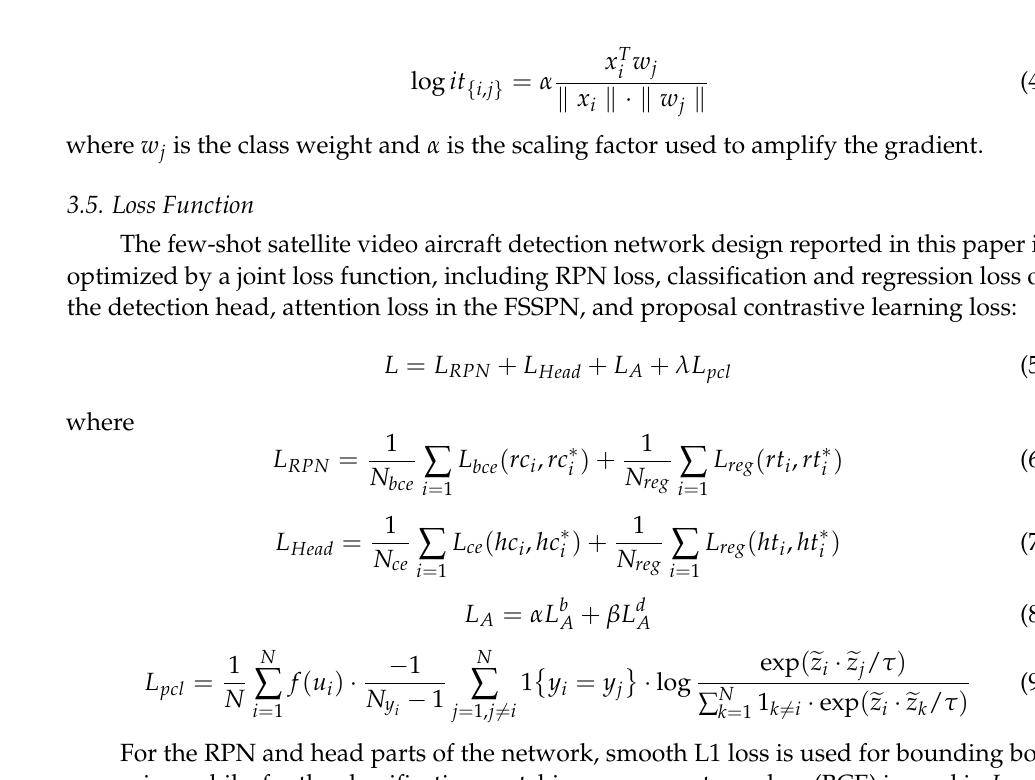
Figure 4. The proposal contrastive learning structure of the